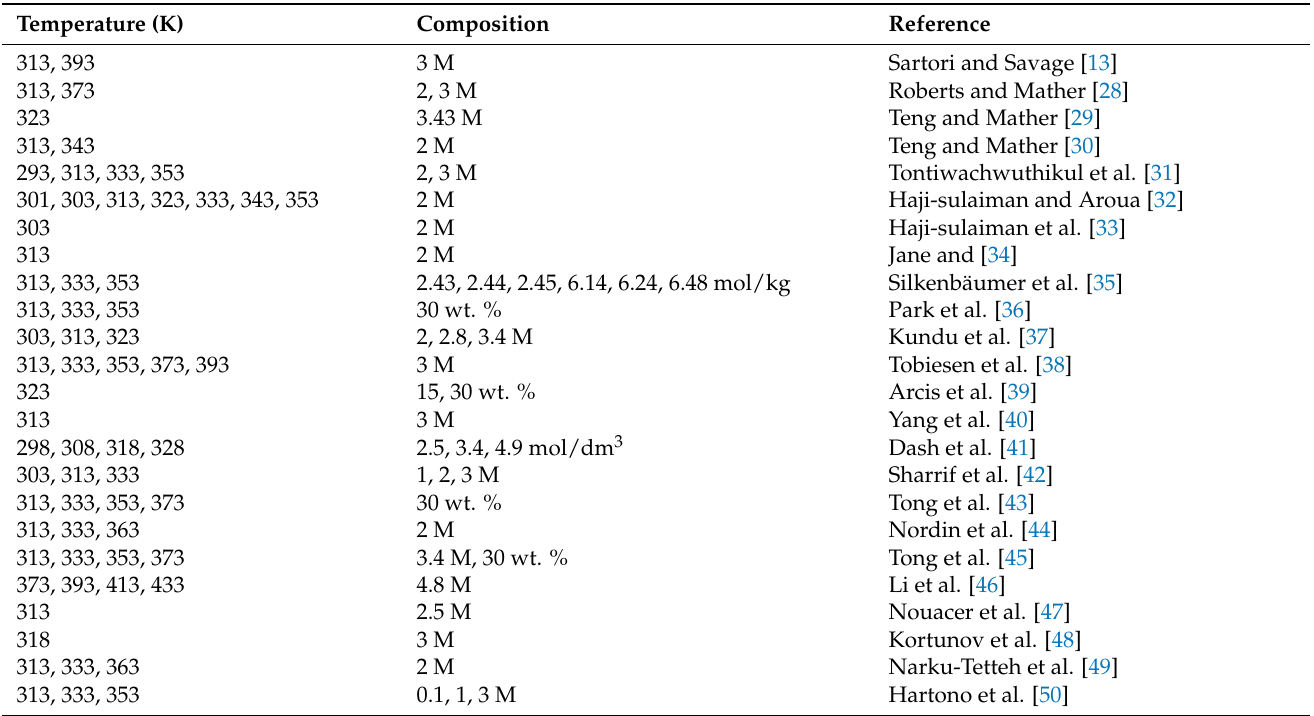
Table 2. Literature studies reporting experimental data for the CO 2 solubility in aqueous AMP